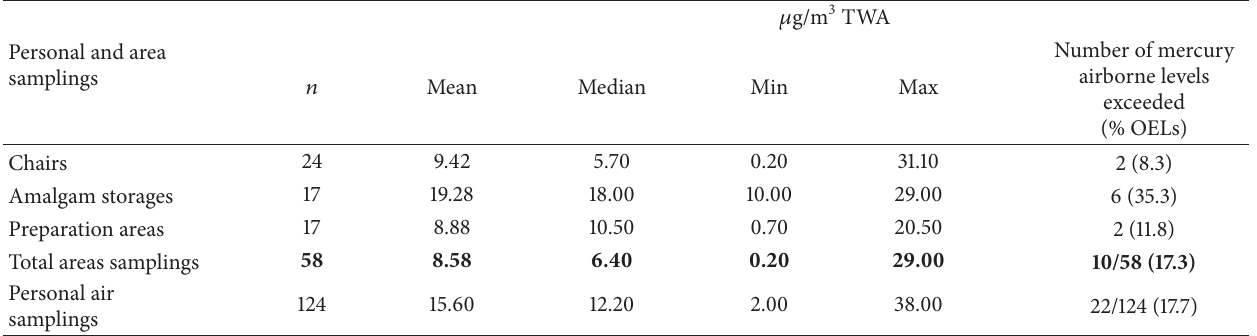
Table 2: Environmental mercury vapor samplings and percentage of mercury airborne levels exceeded (%